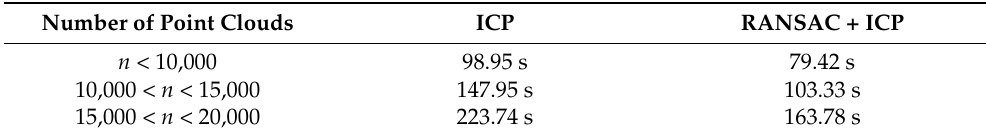
Table 1. Comparison of the average time taken by the two